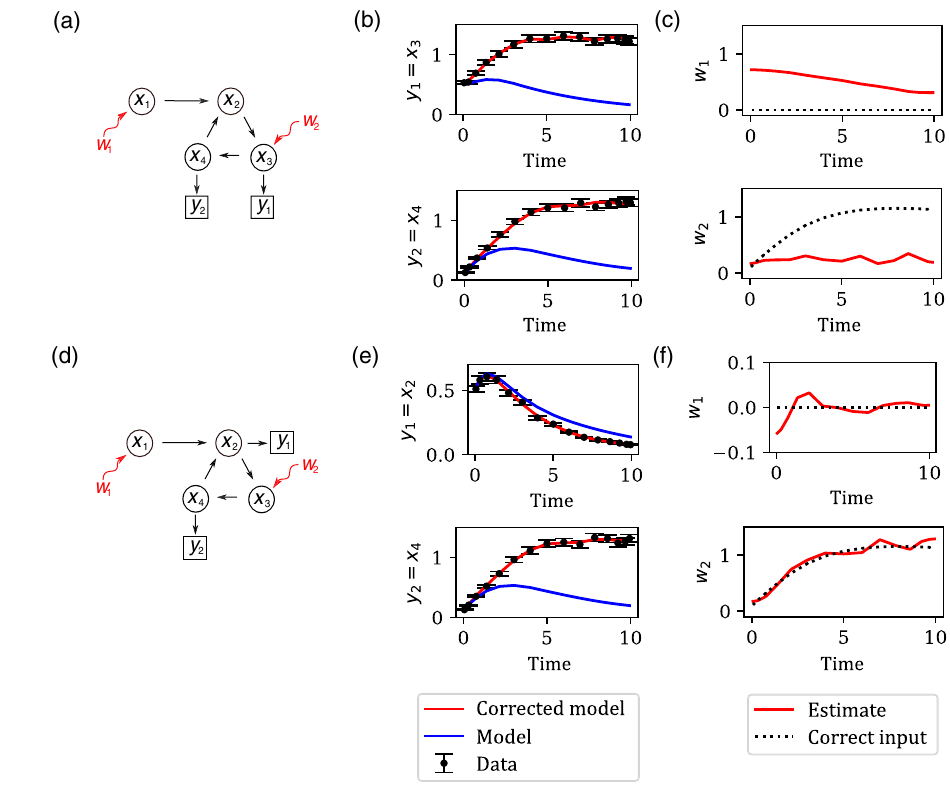
FIG. 5. Estimation of unknown inputs to a simple protein cascade. (a) The influence graph of the system in Eq. (25) with input nodes S ¼ f x 1 ; x 3 g and output nodes y 1 ¼ x 3 and y 2 ¼ x 4 . (b) The model output for the system without unknown inputs (blue line) cannot reproduce the observed data (dots with error bars for measurement noise). Solving the regularized optimization problem [see Eqs. (23) and (24)] provides accurate fits to the data (red line). (c) However, the estimates of the unknown inputs (red lines) are incorrect (dashed lines indicate the true inputs), because the system is not structurally invertible. (d) The system is structurally invertible if y 1 ¼ x 2 and y 2 ¼ x 4 are measured. (e),(f) The fit to the measurements in (e) is now sufficient to estimate the unknown inputs in (f). Please note also the different scale of the plots in (c) and (f). All values are understood in arbitrary